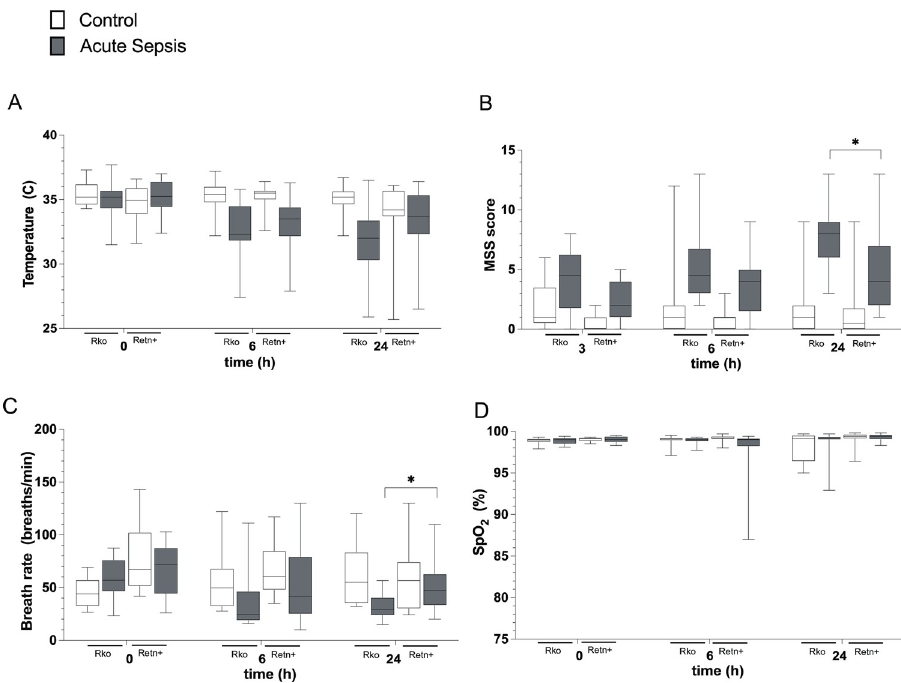
Fig 6. Physiologic parameters at 0 h, 6 h and 24 h post-surgery in mice lacking resistin (Rko) and in mice producing human resistin (Retn+). A, Rectal temperature, B, Mouse Severity of Sepsis Score; C, Breath Rate; D, Oxygen saturation by pulse oximetry. N = 10–25 per group. Box and violin plot line at mean value for each group.